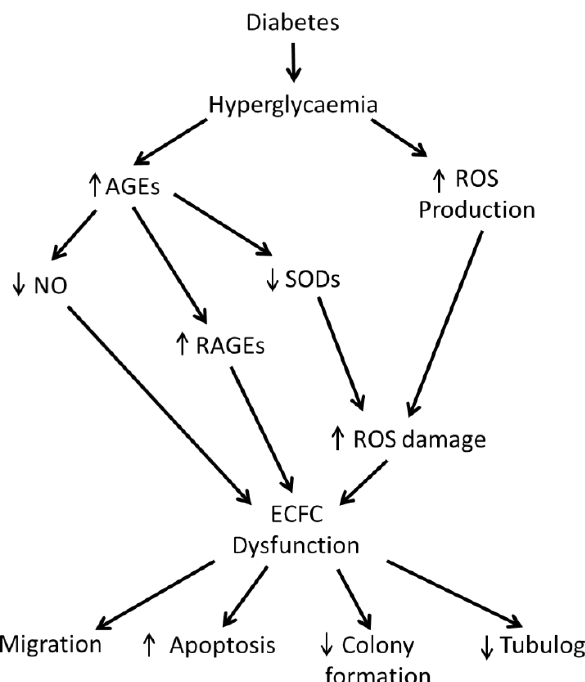
Figure 2. Mechanisms promoting diabetes mellitus (DM) related ECFC dysfunction. AGEs = advanced glycation end-products, NO = nitric oxide, RAGEs = receptor for advanced glycation end-products, ROS = reactive oxygen species.